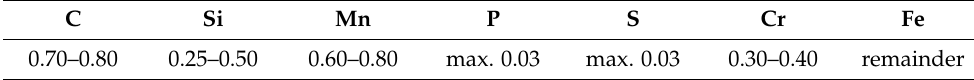
Table 1. Chemical composition of the 75Cr1 steel (%wt.).